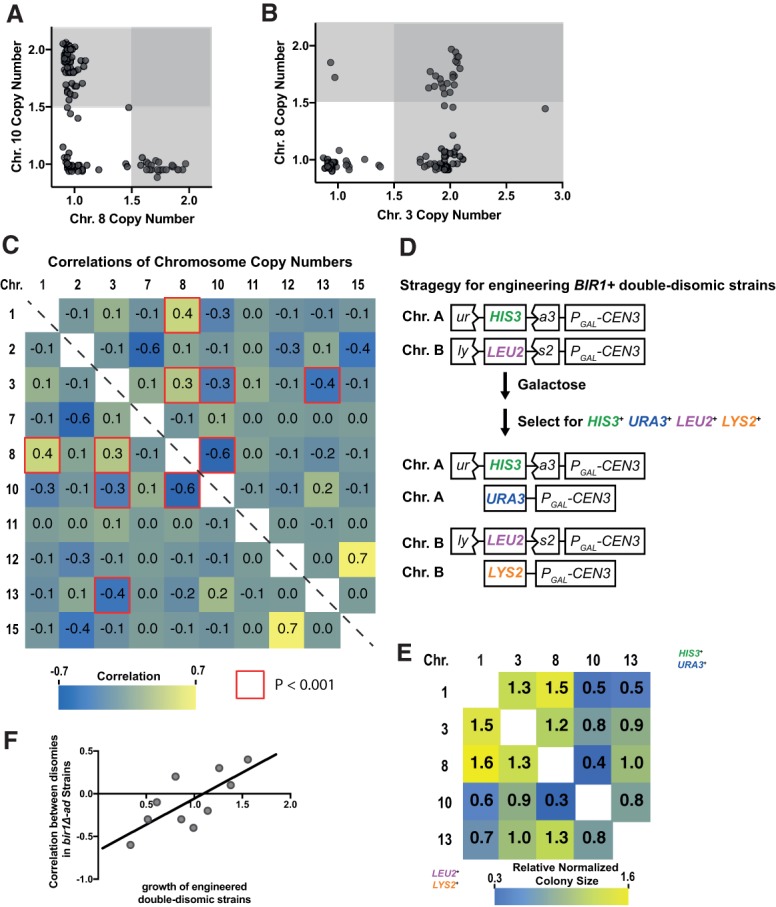
Genetic interactions between whole-chromosome disomies dictate patterns in complex aneuploidy. (A,B) Scatter plot of specific chromosome copy numbers of 102 bir1Δ-ad strains demonstrating positive (B) and negative (A) correlations between different chromosomal disomies. Copy number data are from read frequencies as in Figure 1C. The darker-gray regions contain strains that are aneuploid for both of the plotted chromosomes. (C) Heat map of the correlations between chromosome copy numbers in the 102 haploid bir1Δ-ad strains. Only correlations between chromosomes where aneuploidy was observed are shown. Each cell of the matrix contains the correlation coefficient between the two chromosomes written in the row and column. The red highlighted border represents correlations with P < 0.001 in the hypergeometric test. (D) Schematic of a system to engineered strains (BIR1+) that harbor two chromosome disomies. Strains were transformed with the construct PGAL-CEN3 ura3::HIS3 on one chromosome (chromosome A) and PGAL-CEN3 lys2::LEU2 on another chromosome (chromosome B). Chromosome nondisjunction was induced with galactose, and disomy of both chromosomes was selected for with all four auxotrophic markers (URA3, HIS3, LYS2, and LEU2). (E) Relative colony sizes of double-disomic strains on YPAD plates were normalized to the other values in their respective rows and columns. Colony sizes without normalization are shown in Supplemental Figure S2I. (F) Comparison of the correlation coefficients of the chromosome copy numbers in bir1Δ-ad strains (from C) and the relative fitness of engineered double-disomic strains (from E). Relative values are the average of the two values in E (column:row and row:column for each chromosome pair). Pearson's correlation coefficient = 0.73. Two-tailed P-value = 0.016.